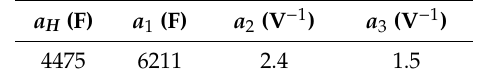
Table 1. The identified parameters of the modified Stern model.